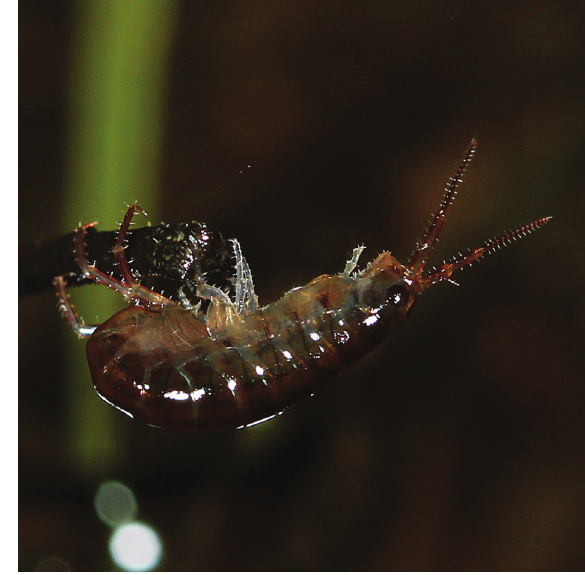
Figure 1. Map of the Inner Gulf of Thailand and the collection site (Sam Roi Yod National Park).